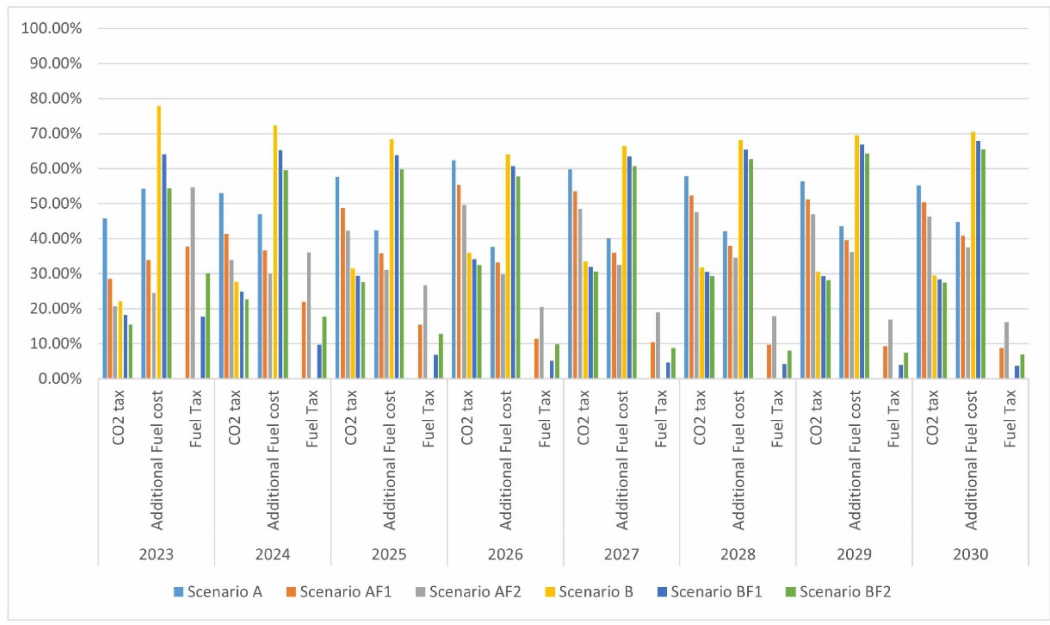
Figure 8. Breakdown of taxplus projections from 2023 to 2030 based on scenarios A, AF1, AF2, B, BF1, and BF2 for intra-EU imports/exports.